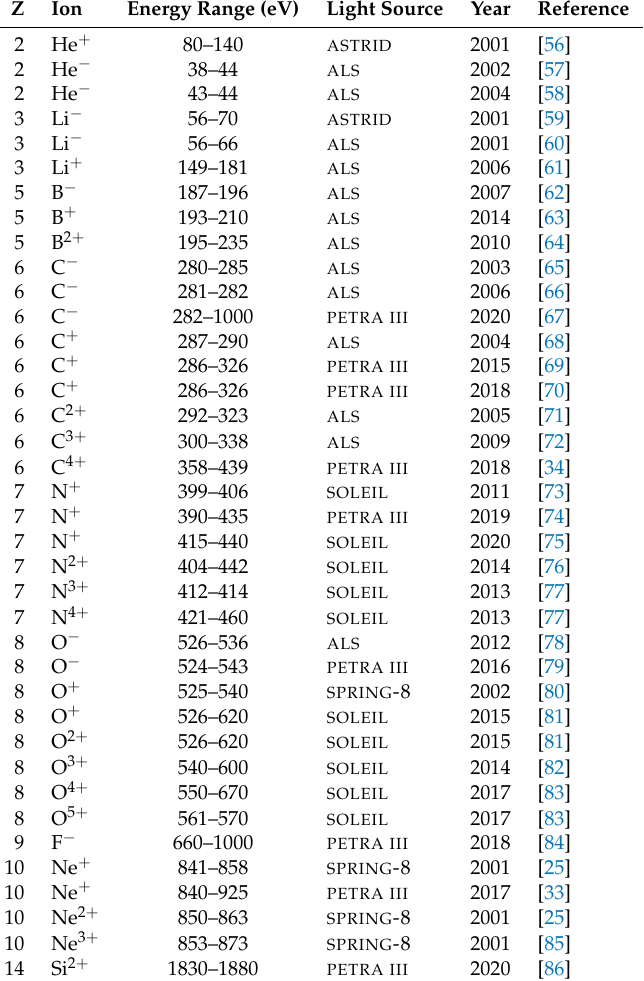
Table 1. List of published experimental cross sections for K -shell photoionization of atomic ions with atomic numbers Z ≥ 2 from photon-ion merged-beams experiments at the synchrotron light sources ALS (Berkeley, CA, USA), ASTRID (Aarhus, Denmark), PETRAIII (Hamburg, Germany), SOLEIL (Saint-Aubin, France), and SPring-8 (Hyogo, Japan). Columns 3 and 5 provide the experimental photon-energy range and the year of publication,